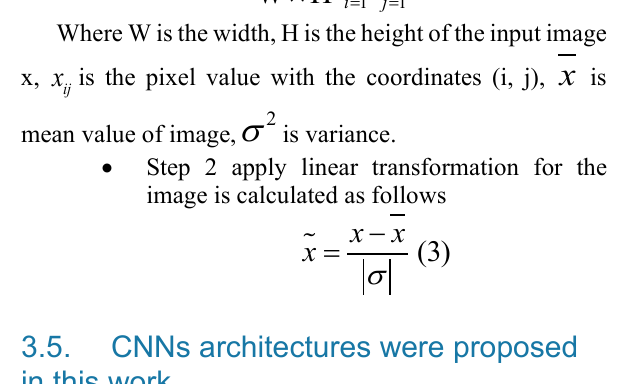
Figure 6. Illustrate all stage of MTCNN